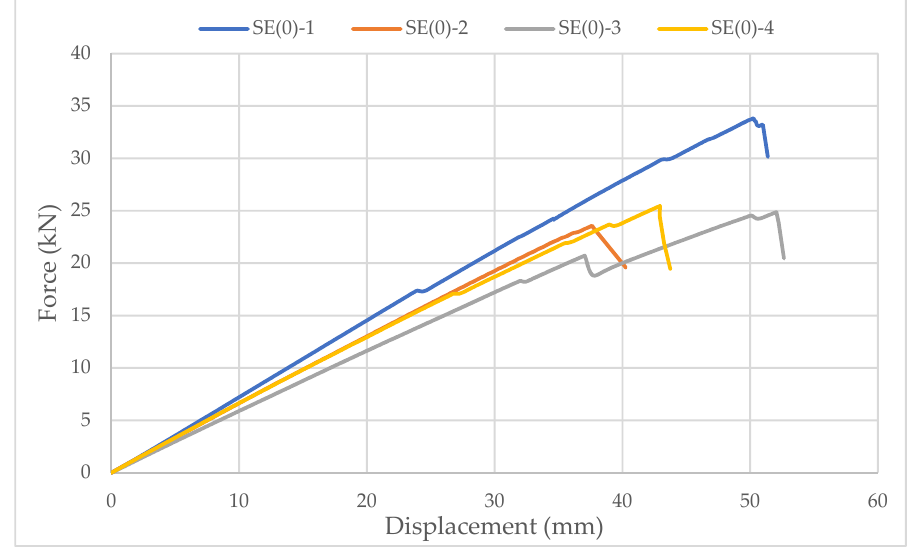
Figure 13. Force-displacement curve for strong-axis bending of samples with elliptical cavities.